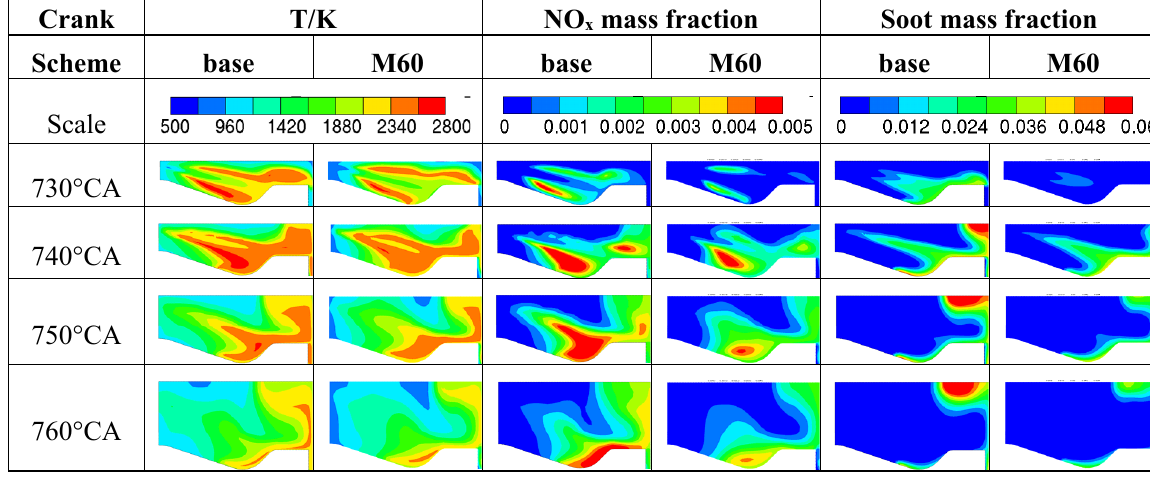
Figure 11. Contour images comparison of temperature, NO x , and soot mass fraction between M60 and baseline